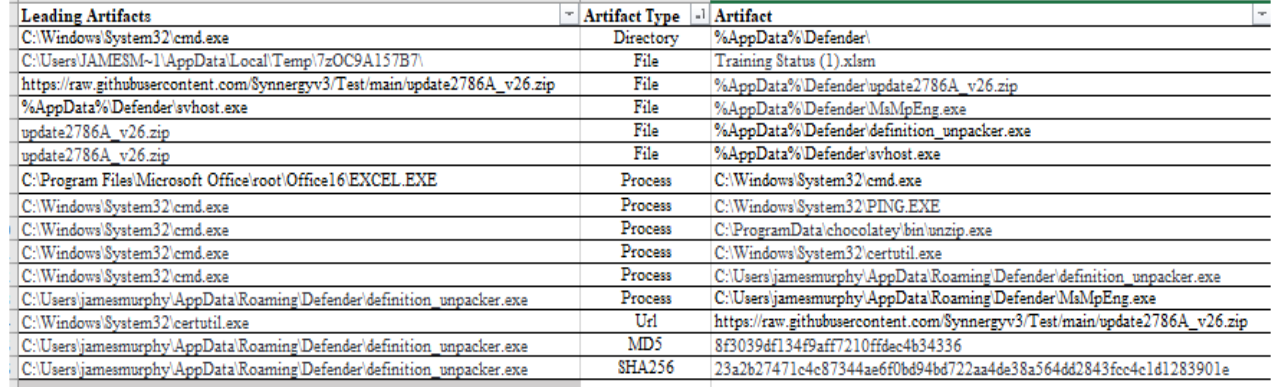
Figure 19. Hunt artifacts uncovered.